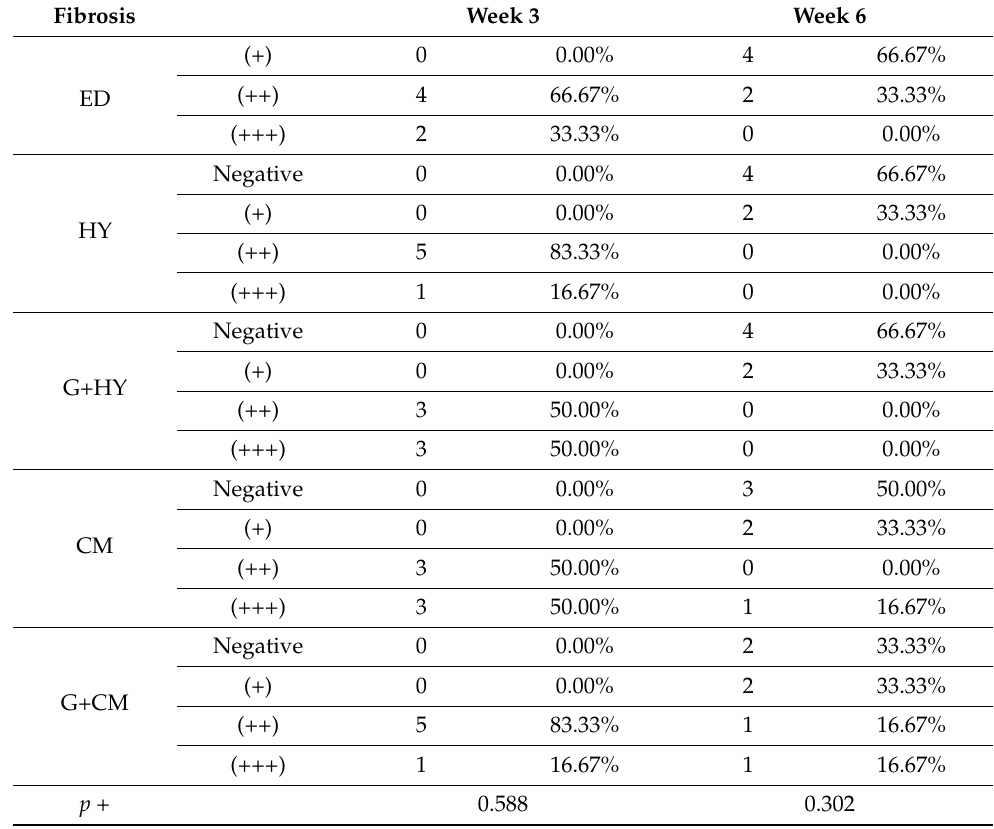
Table 3. Fibrosis scores in the 3rd and 6th weeks. A chi-square test was used.